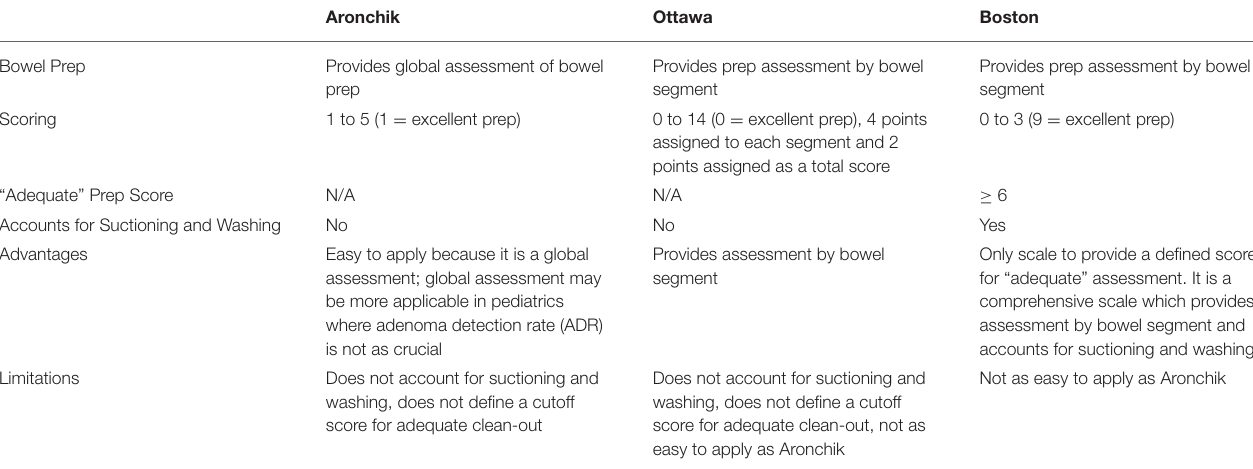
TABLE 1 | Bowel preparation assessment scales.